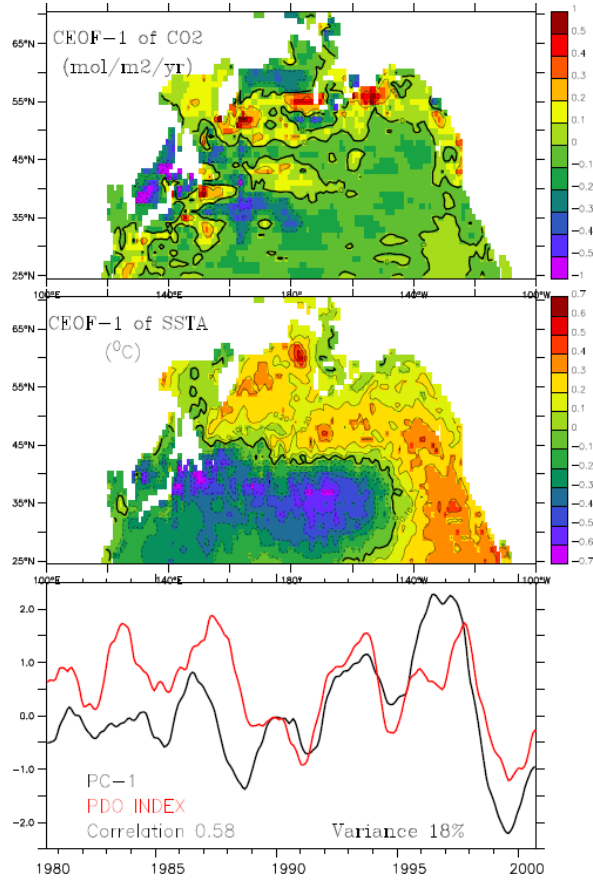
Figure 9: (top) The spatial pattern of CEOF-1 for net air-to-sea CO 2 flux anomalies (negative represents 3 Fig. 9. (top) The spatial pattern of CEOF-1 for net air-to-sea CO 2 CO 2 flux from atmosphere to ocean and vice versa) and (middle) that for SST anomalies. (bottom) 4 flux anomalies (negative represents CO 2 flux from atmosphere to PC-1 (black-line) and PDO (redline). Time-series are significantly correlated above the 5% level. 5 ocean and vice versa) and (middle) that for SST anomalies. (bot- tom) PC-1 (black-line) and PDO (redline). Time-series are signifi- cantly correlated above the 5% level.